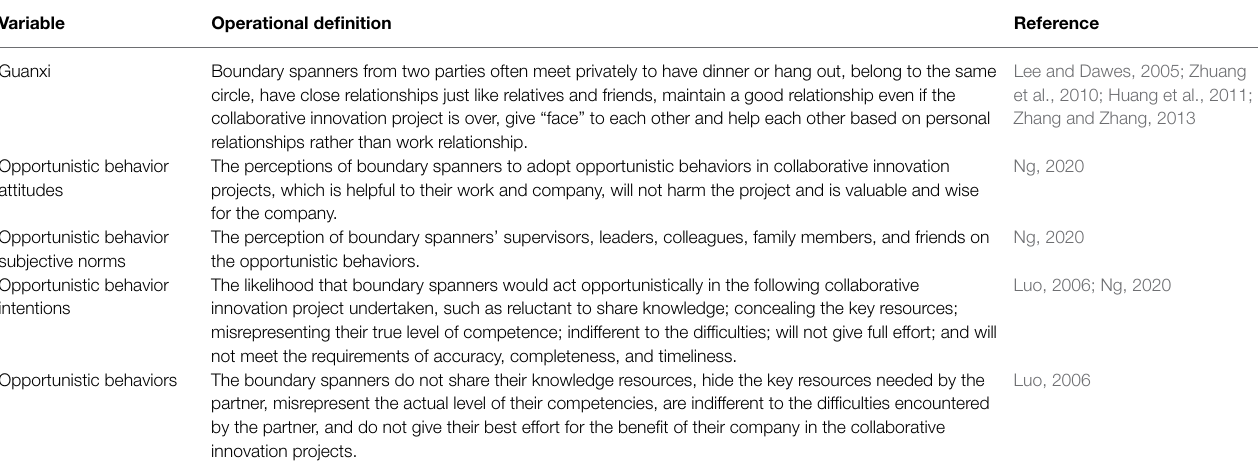
TABLE 1 | Operational definition and reference resources of each latent